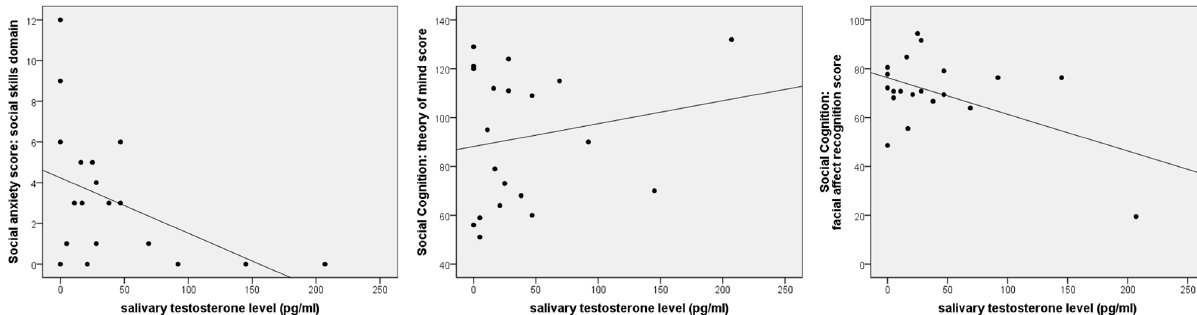
Fig 2. Scatterplots of the relationship between salivary testosterone level and parameters of social anxiety and social cognition (theory of mind and facial affect recognition) in the 47,XXY group.